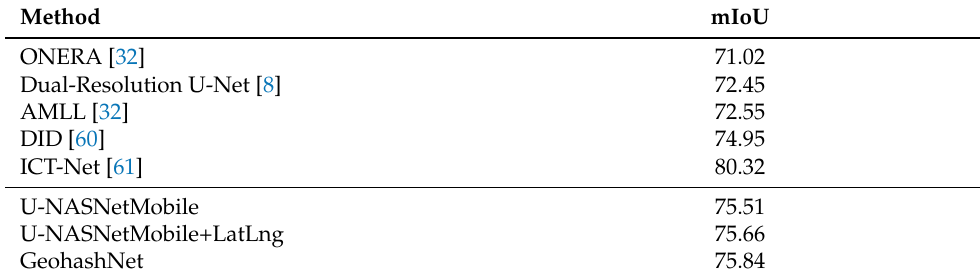
Table 5. Results for different methods on the Inria